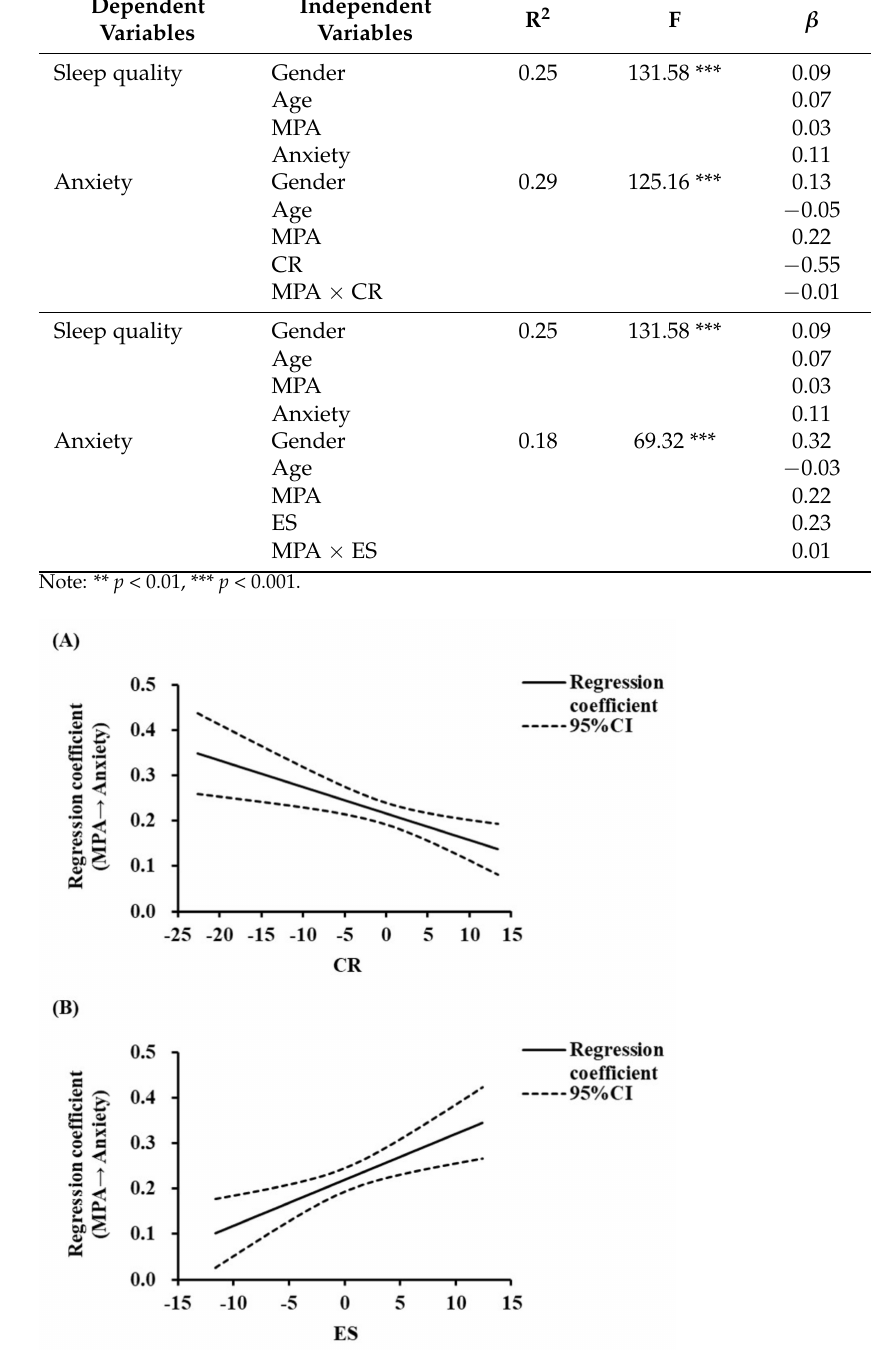
Figure 2. ( A , B ). The moderating effect of CR and ES on the relationship between MPA and anxiety. ( A ) shows the interaction between MPA and CR, and ( B ) shows the interaction between MPA and